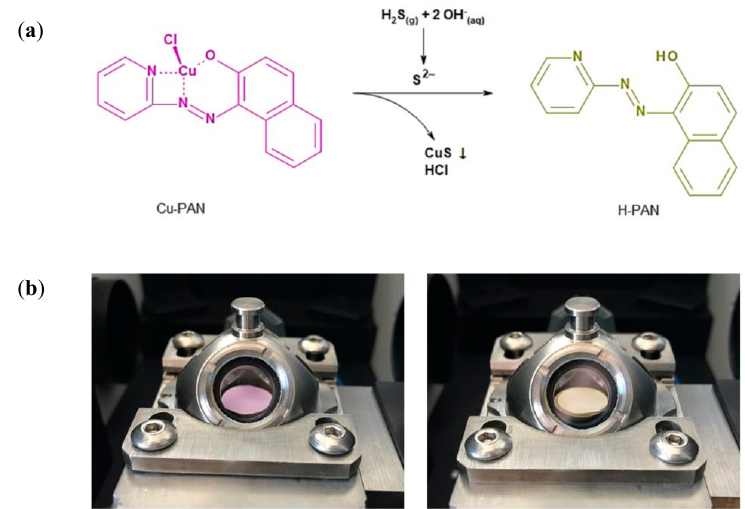
Figure 1. ( a ) Possible sensing mechanism of the Cu-PAN complex according to Carpenter et al. [3]: Reaction of H 2 S (g) with OH − (aq) to S 2 − leading to a reaction of S 2 − with the Cu-PAN complex resulting in CuS and free the yellow azo dye H-PAN. ( b ) Images of the Cu-PAN paper test stripe before the gas exposure ( left ) and after treating with 20 ppm H 2 S for 20 min ( right ).